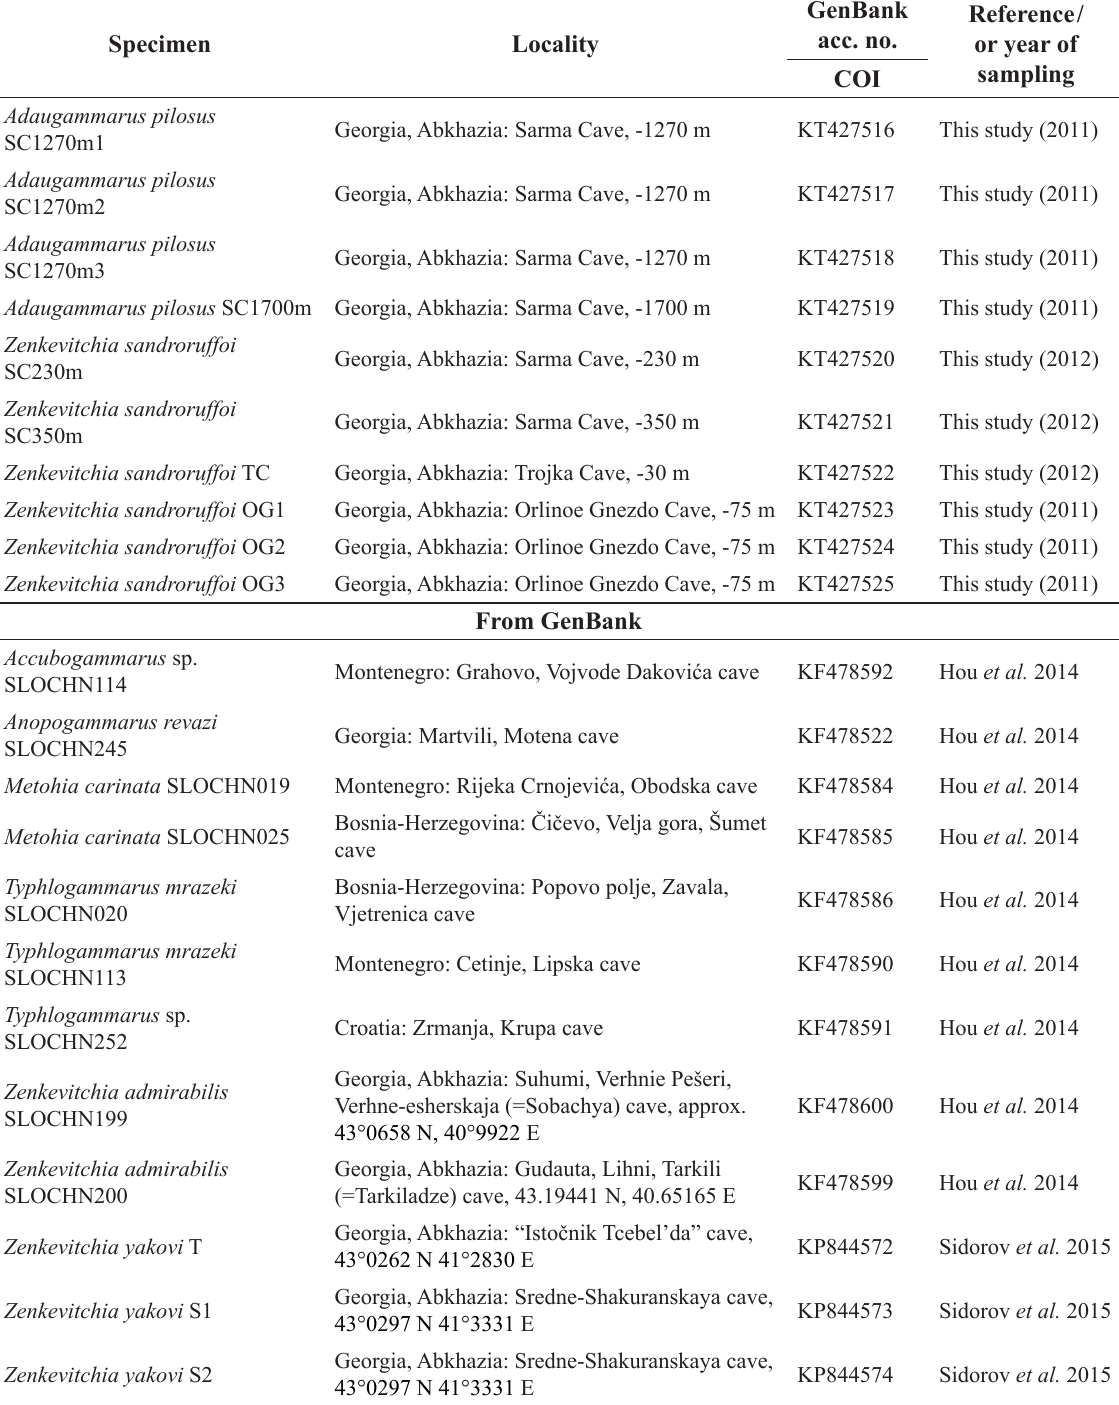
Table 1. List of the specimens, sampling sites and accession numbers of the sequences included in this study. References are given for sequences obtained from